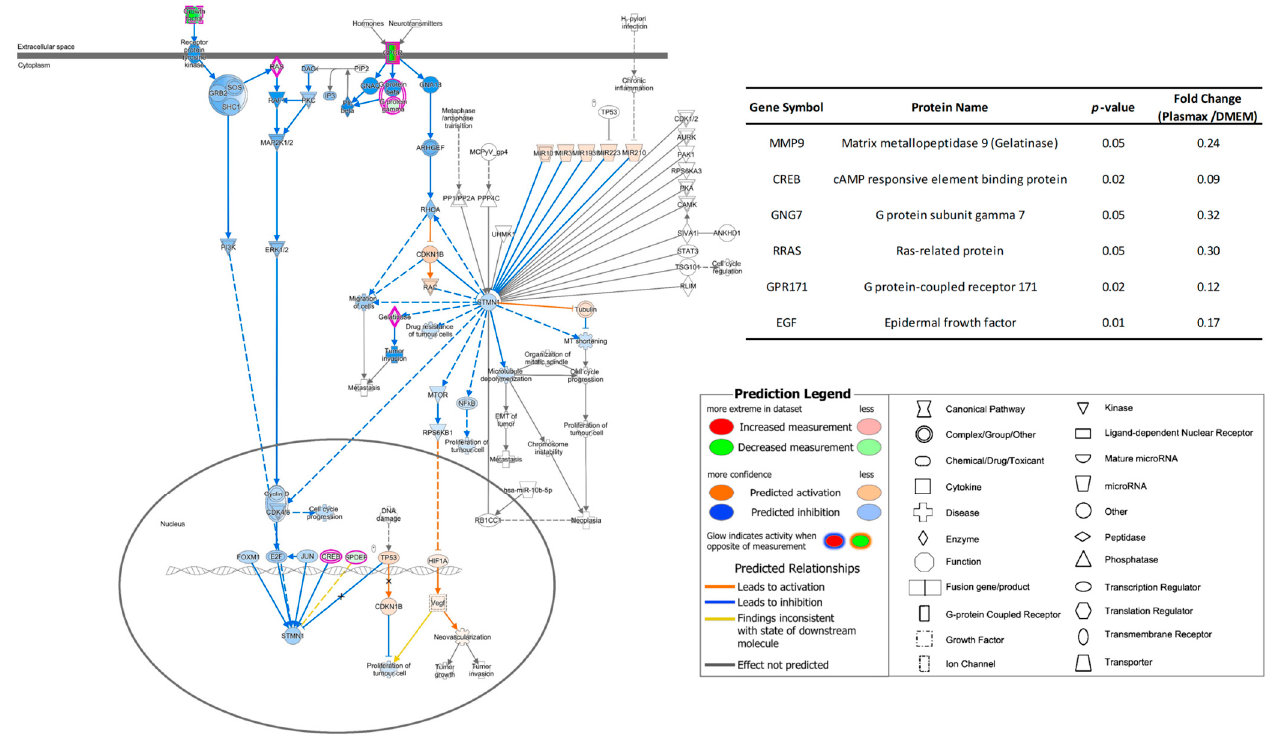
Figure 2. Inhibited pathway of breast cancer regulation by stathmin 1 of 231BR cell line cultivated by Plasmax compared to DMEM. Blue line denotes that the corresponding protein change cause an inhibition to the function in Plasmax. Orange line denotes that the corresponding protein change cause an activation to the function in Plasmax, and yellow line denotes the inconsistent changes of corresponding proteins and their downstream molecules. The inset table provides the p -values and fold-change numbers of transcriptomes that are involved in this pathway.